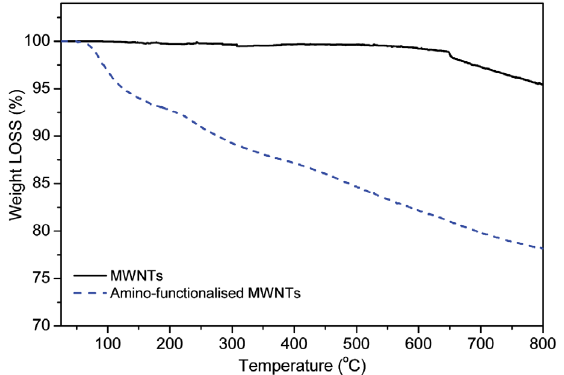
Figure 2. Thermal gravimetric analysis (TGA) plot for pristine MWNT and amino-functionalised